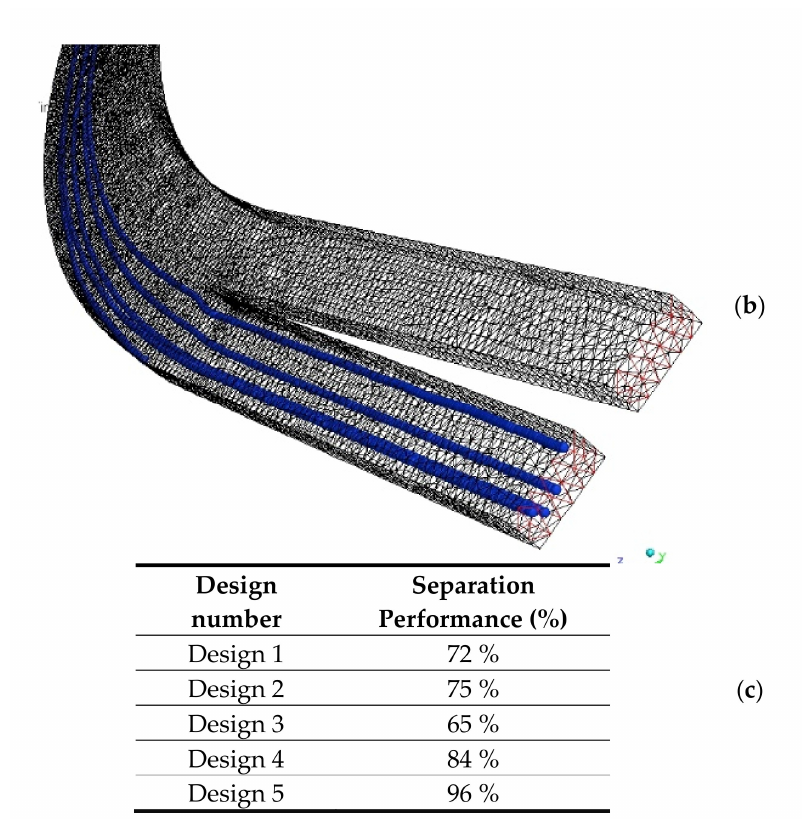
Figure 5. Simulation of particle separation in microfluidics for in-line filtering of the inlet air containing particle pollution; ( a ) design 1; ( b ) design 5; ( c ) separation performance of each